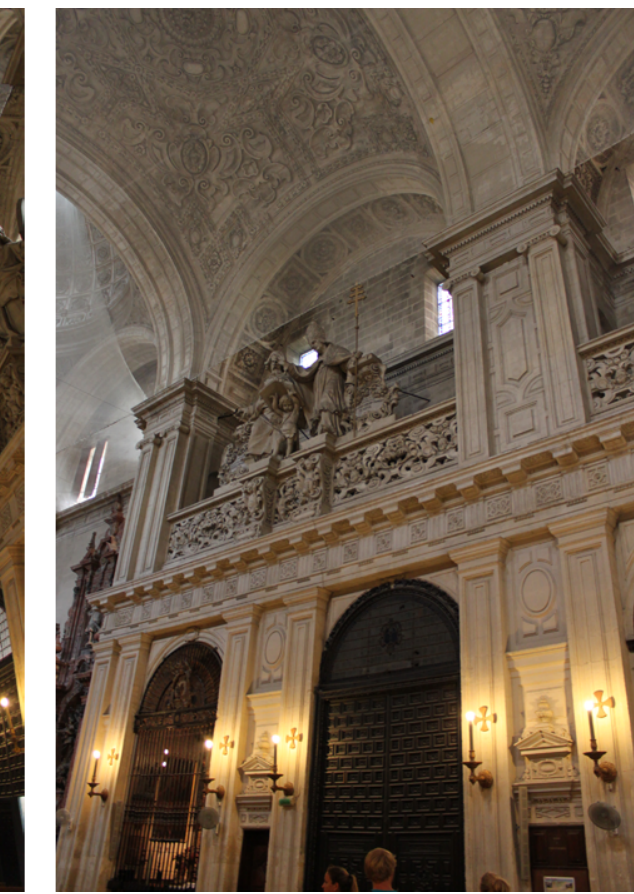
Figure 8: Interior of the Sagrario. Termination of the nave. The door that connects the Sagrario with the Cathedral is at the base of the image. The carving work by the Bor- jas can be seen in the vaults above. Image from http:// www.flickr.com/photos/turismosevilla/5903717101/ in/photostream/. Photo by Turismo de Sevilla (Creative Commons license).